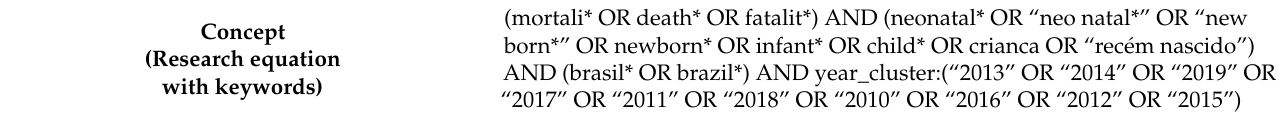
Table A4. Research SCIELO (1206 references).